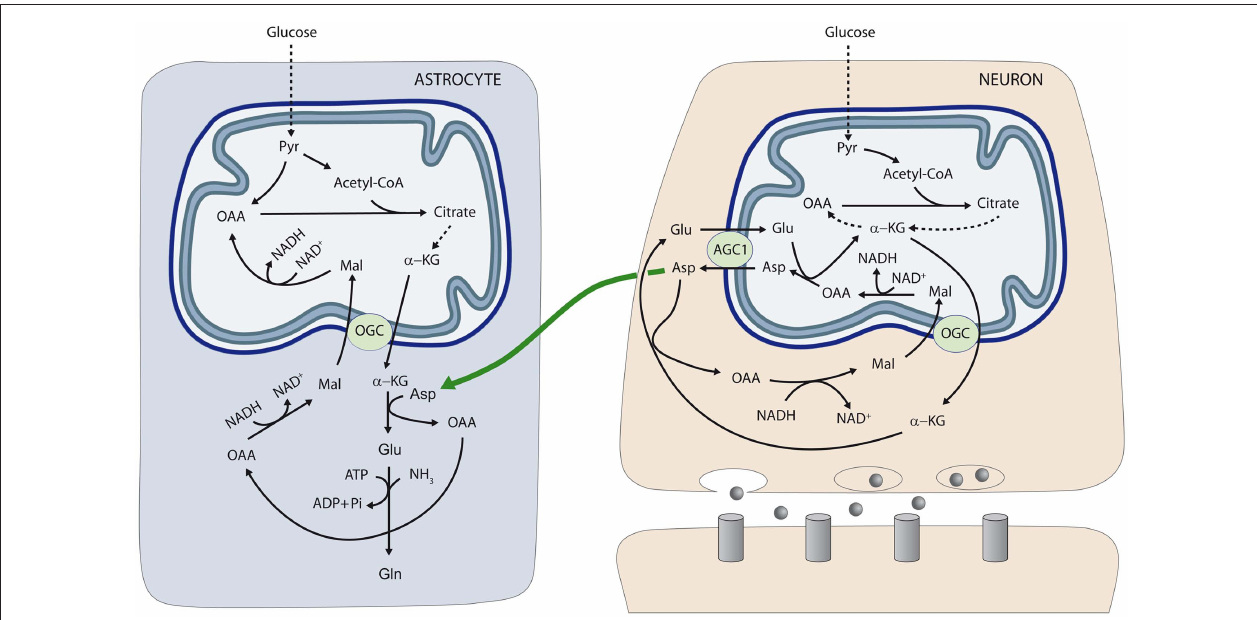
FiGurE 1 | Neuron-to-glia transcellular aspartate efflux pathway for glial glutamate synthesis. Neuronal mitochondria are provided with aralar/AGC1/ Slc25a12 and the oxoglutarate carrier/OGC/Slc25a11 and carry out the malate-aspartate shuttle to transfer NADH reducing equivalents to the mitochondrial matrix. AGC1 is irreversible in polarized mitochondria and the main pathway of glutamate supply to the mitochondrial matrix. As cAST functions in the direction of glutamate formation in cells with an active MAS, mitochondria are the only site where aspartate is produced (in the mitochondrial aspartate aminotransferase reaction), and aspartate leaves the matrix through AGC1 to reach the cytosol. De novo glutamate synthesis in astroglial cells takes place in the cytosol in the cAST reaction with aspartate as amino-nitrogen donor to α -KG. A second amino group (possibly arising from ammonia itself formed in neurons in the phosphate-activated glutaminase reaction, or imported from the blood stream) is acquired in the glutamine synthetase reaction and glial glutamine is now transferred to neurons along the glutamate–glutamine cycle (not shown). Oxaloacetate (OAA) arising from the cAST reaction is converted to malate, and